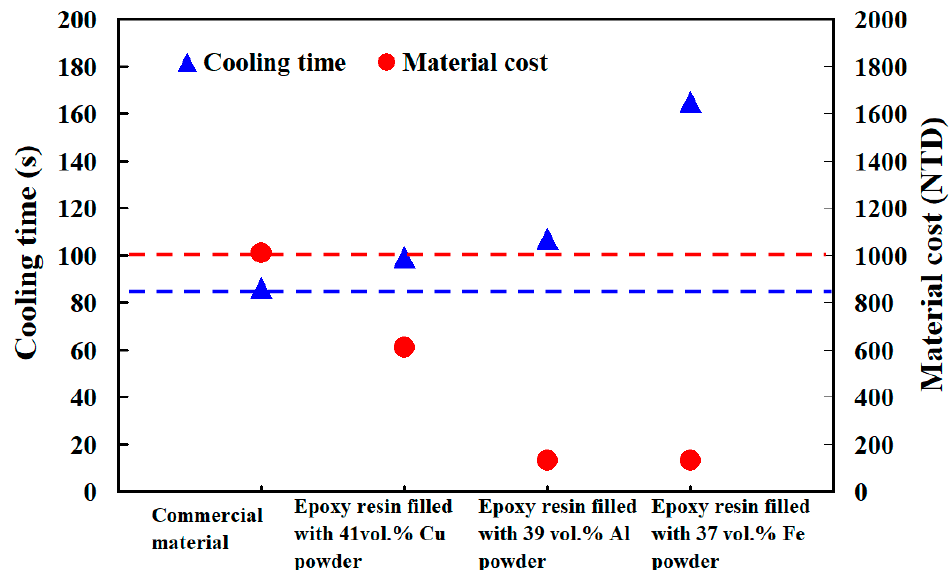
Figure 25. Four different kinds injection molds of material cost and cooling time of the wax pattern.